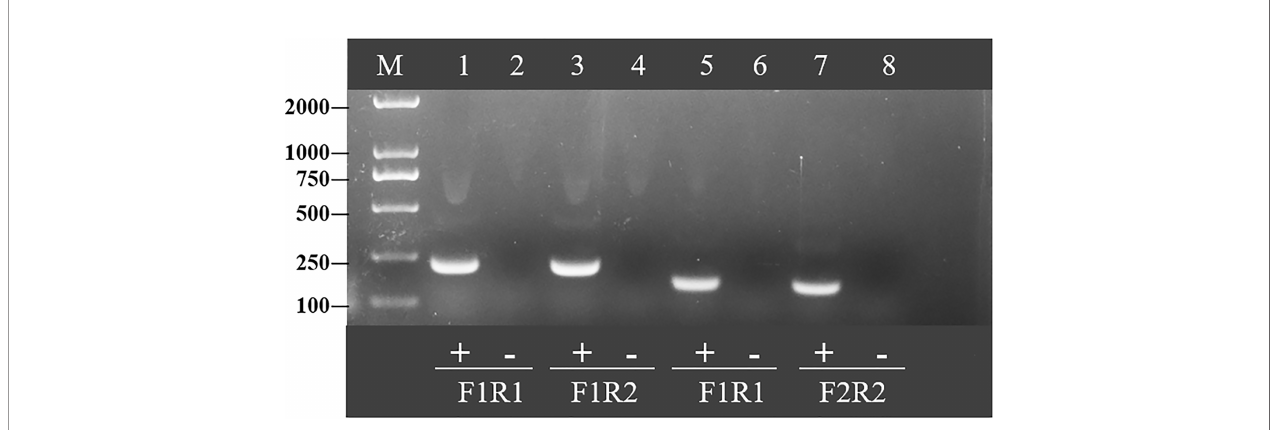
FIGURE 2 | Optimal primer selection. Products ampli fi ed by different reverse transcription recombinase-aided ampli fi cation primers were analyzed by 1.5% agarose gel electrophoresis to select the optimal primer pairs. M is a 2,000-bp DNA marker. The primers and templates used in lanes 1 – 8 are as follows: 1, HCV-RAA-F1/ R1 + HCV; 2, HCV-RAA-F1/R1 + ddH 2 O; 3, HCV-RAA-F1/R2 + HCV; 4, HCV-RAA-F1/R2 + ddH 2 O; 5, HCV-RAA-F2/R1 + HCV; 6, HCV-RAA-F2/R1 + ddH 2 O; 7, HCV-RAA-F2/R2 + HCV; 8, HCV-RAA-F2/R2 + ddH 2